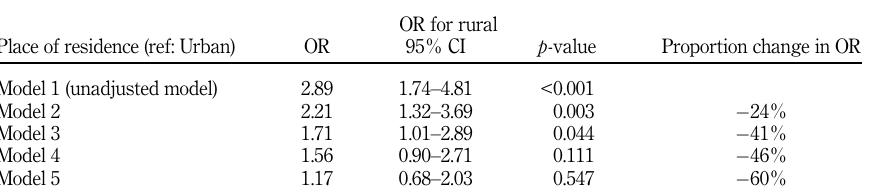
Table 3. Change in effect